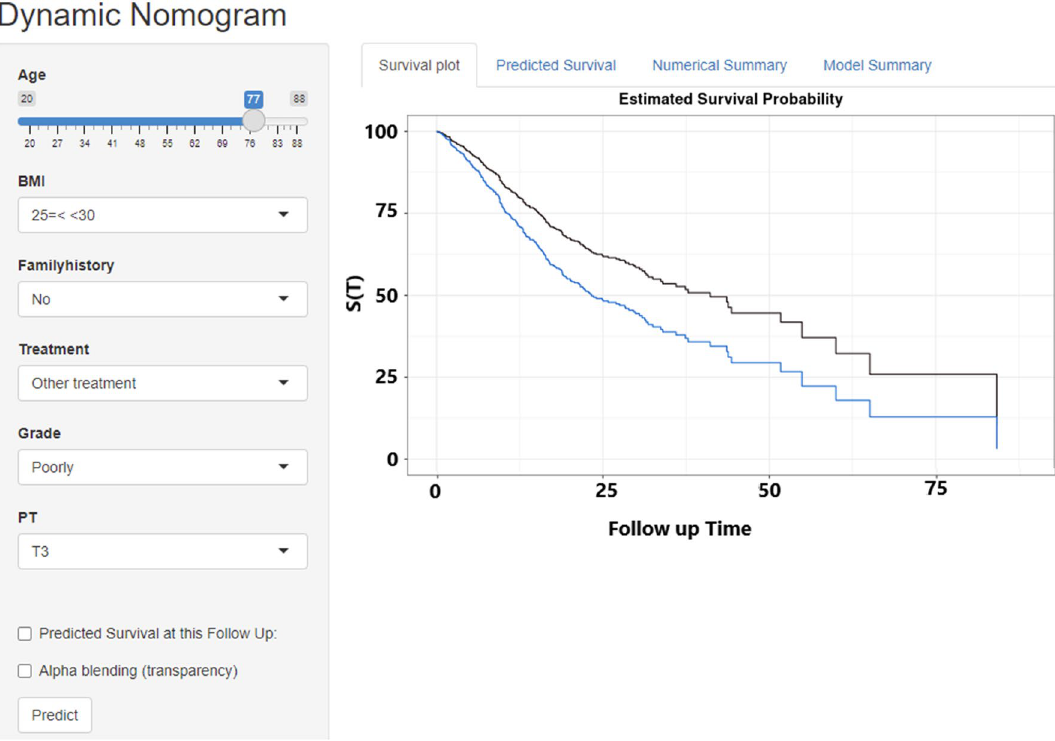
Figure 3. Web-based survival rate calculator (Dynamic Nomogram (shinyapps.io)) to predict the survival of GC patients; Two patients who are 77 years old, no surgery, no family history, PT3 and 25 ≤ BMI < 30, but have different grade, well (black line) and poorly (blue line), according to the web survival rate